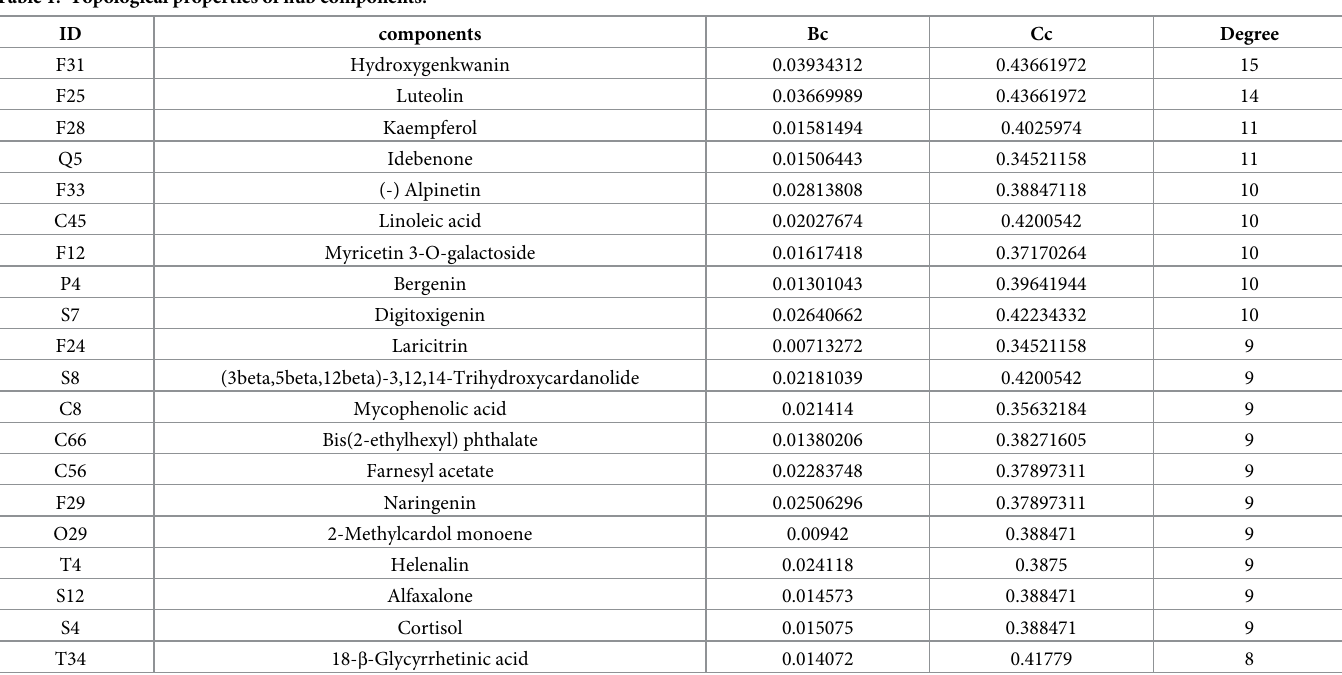
Table 1. Topological properties of hub components.